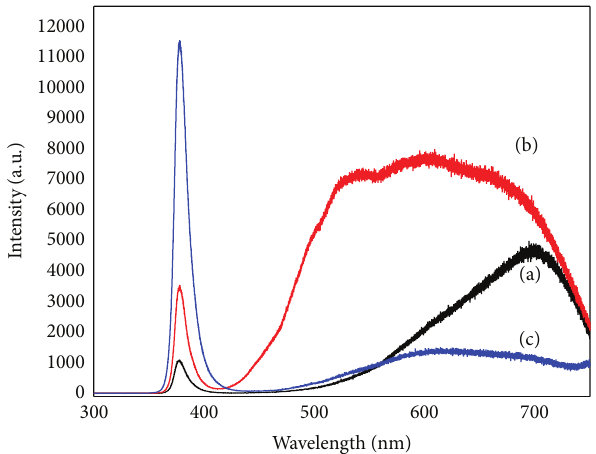
Figure 5: PL spectra for sample: (a) 1V, (b) 2 V, and (c) 3V (excitation: 𝜆 = 514